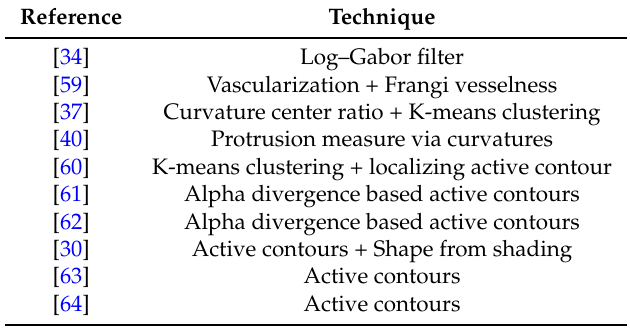
Table 2. Methods available for polyp localization and segmentation within a VCE